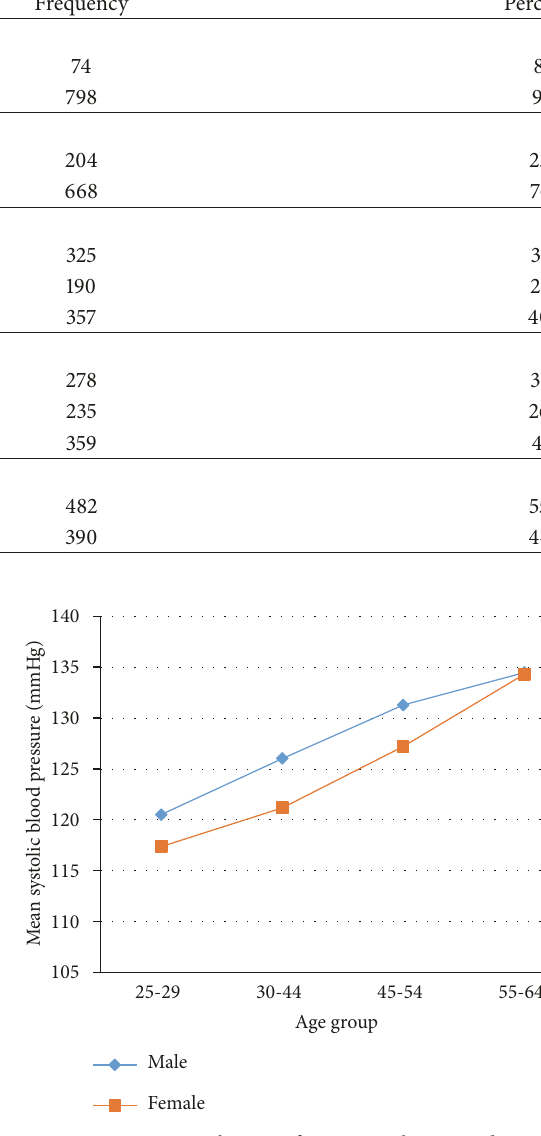
Figure 1: Distribution of mean SBP by age and